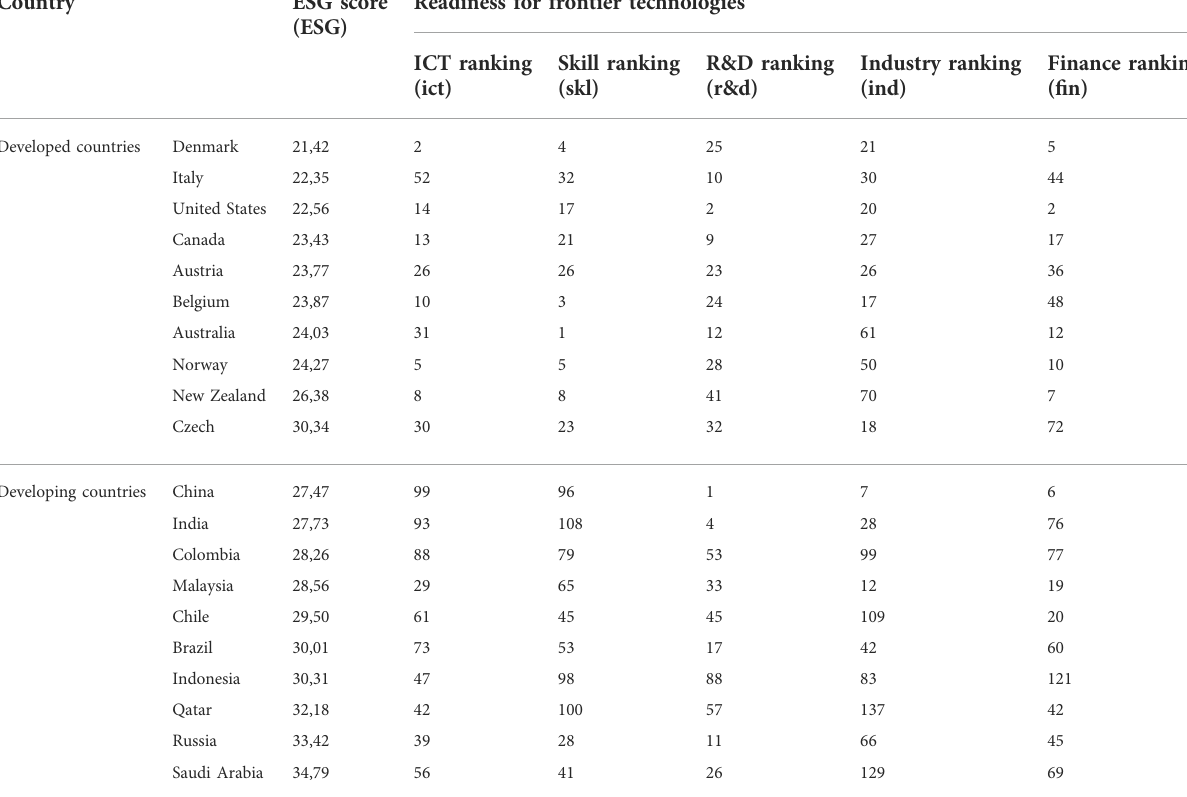
TABLE 1 ESG investments and readiness for frontier technologies in developed and developing countries in 2021. Country ESG score (ESG)